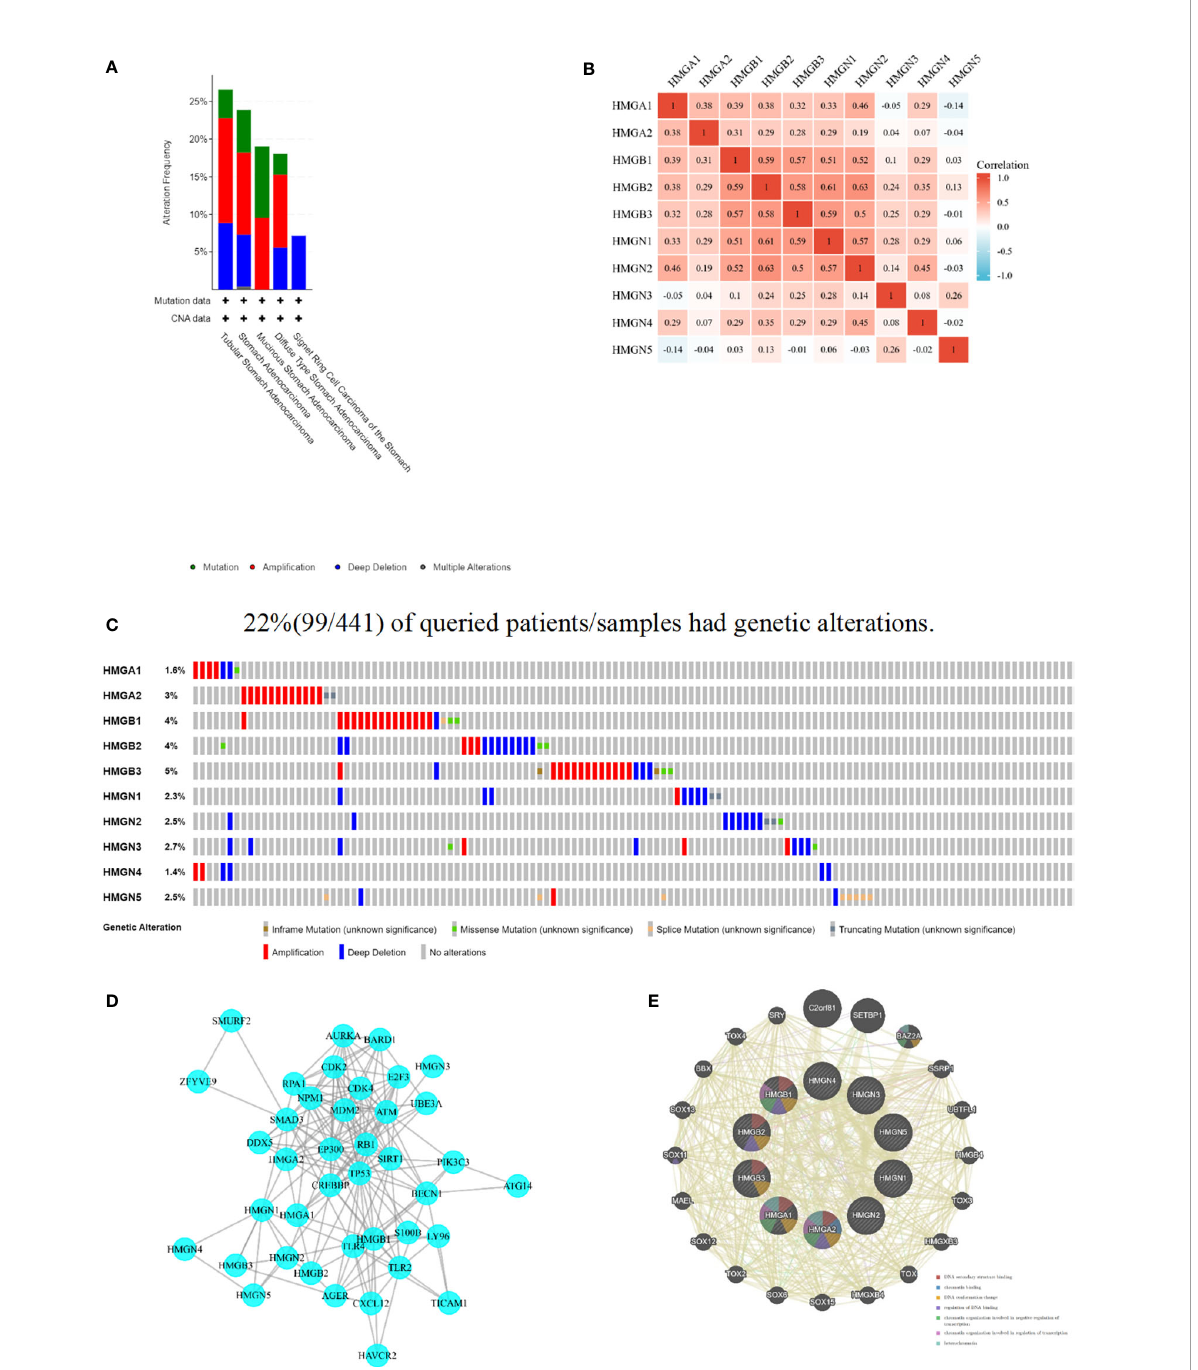
FIGURE 7 Mutation and correlation analysis of HMGs in GC. (A) Mutation frequency of HMGs; (B) correlation between every two HMGs; (C) Mutation speci fi cs of every HMGs in each sample; (D, E) Protein-protein interaction network of different expressed